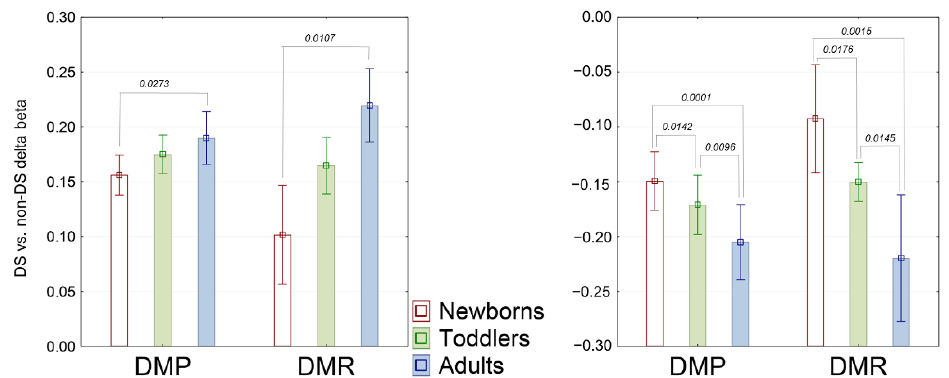
Figure 9. A comparison of the means of the delta-beta values of the DS-associated DNA methylation signals—differentially methylated positions (DMP) and regions (DMR)—across the three age groups. Whiskers depict the confidence interval for each mean. The left and right panels represent the data for the hypermethylated and hypomethylated DMPs and DMRs, respectively. Only statistically significant p -values ( p < 0.05) for the paired t -tests are shown.